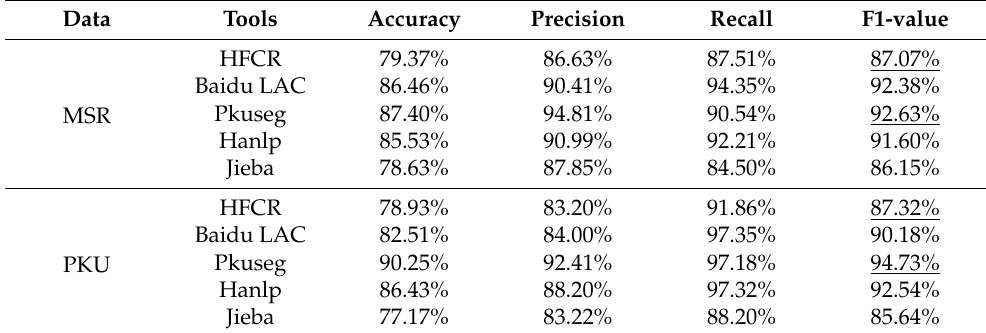
Table 5. Comparison of accuracy between HFCR algorithm and other tokenizers (general text).